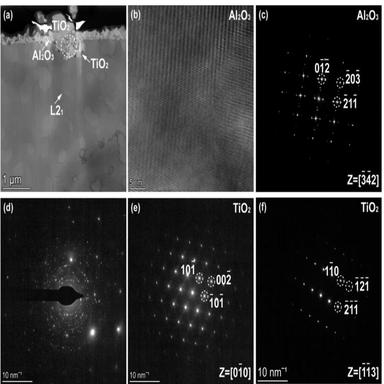
Phase structure of the oxide scale of Al16 CCA after 100 h oxidation at 800 ◦C in air identified by TEM analysis: (a) BF image, (b, c) HR-TEM and SAED pattern shows the Al2O3 oxides, (d) The SAED pattern corresponding to the white dashed line in Fig. 9a, showing the nano grain morphology, (e) The SAED corresponding to the TiO2, (f) The SAED pattern corresponding to the SAED of TiO2.